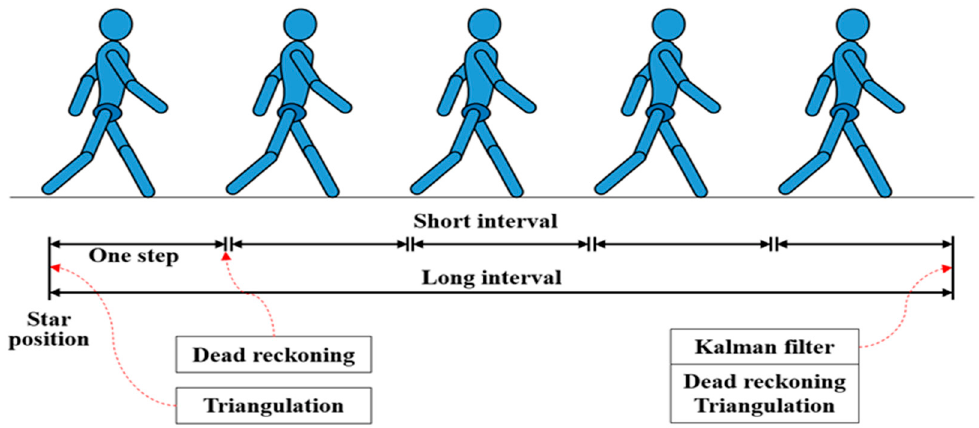
Figure 7. Diagram of two positioning phases.